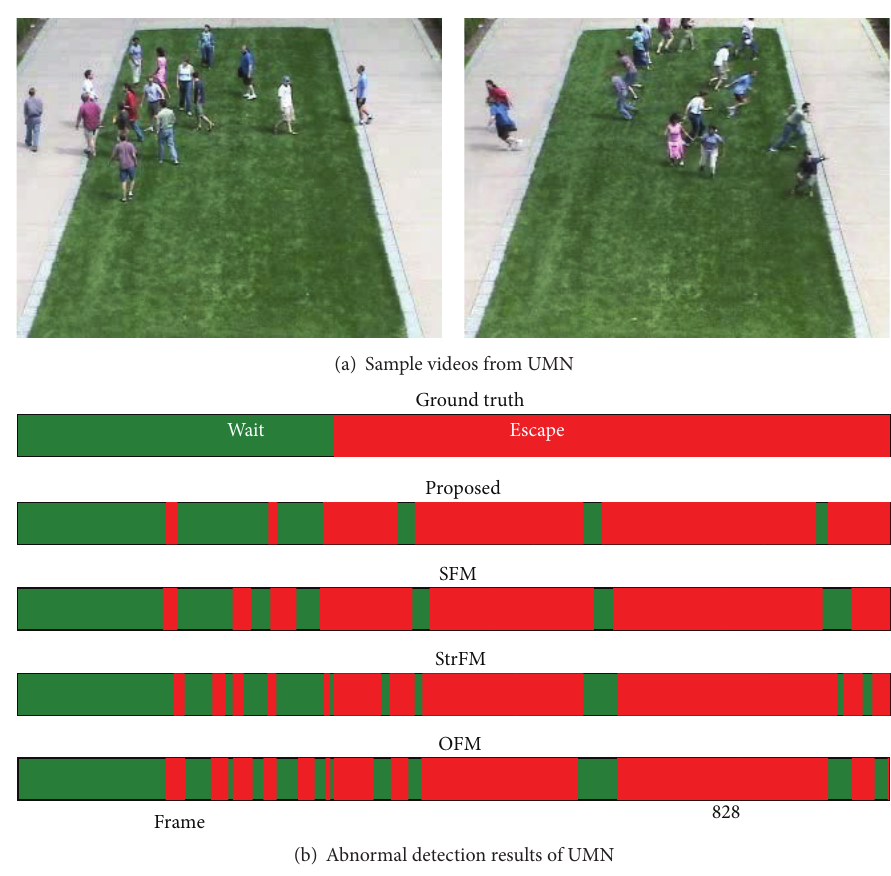
Figure 8: Comparison results of abnormal detection for sample videos from